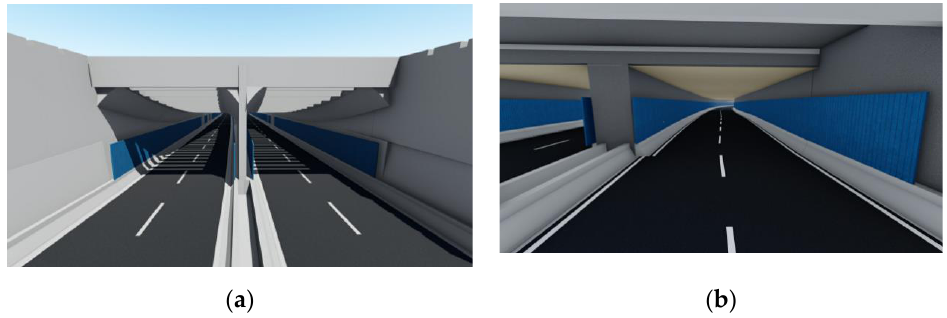
Figure 3. Example of the tunnel BIM modeling: ( a ) BIM modeling example of the tunnel entrance; ( b ) BIM modeling example of the tunnel exit. ( b ) BIM modeling example of the tunnel